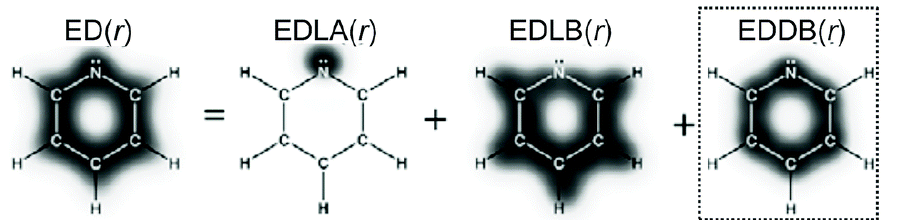
Figure 9. Decomposition of total electron density, ED(r), into three contributions. Adapted from Ref. [117] with permission from the PCCP Owner Societies. Copyright (2017) with permission from Royal Society of Chemistry.